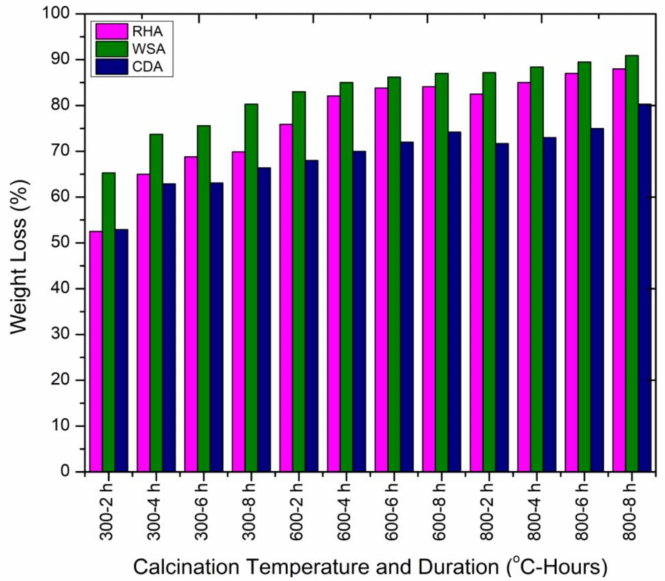
Figure 8. Weight loss of RHA, WSA, and CDA samples at different incineration